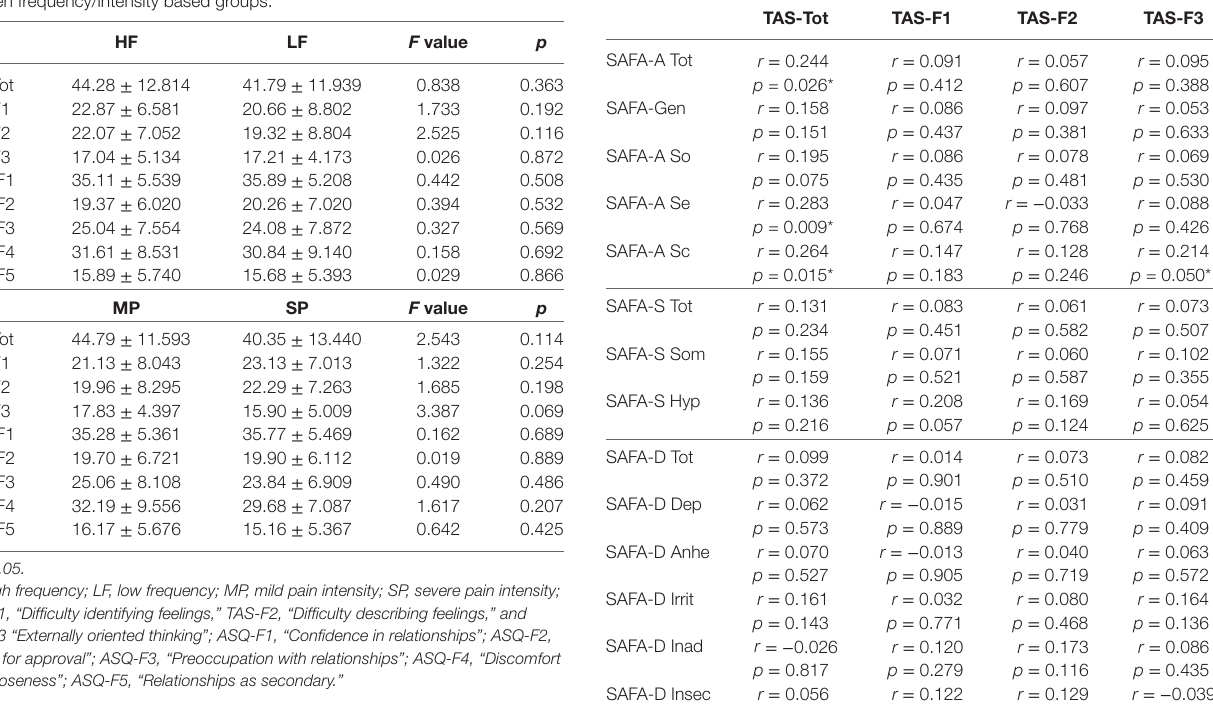
Table 6 | Correlation between TAS-20 and SAFA-A, S, and D. Table 5 | Maternal TAS-20, ASQ scores (mean ± SD), and ANOVA among